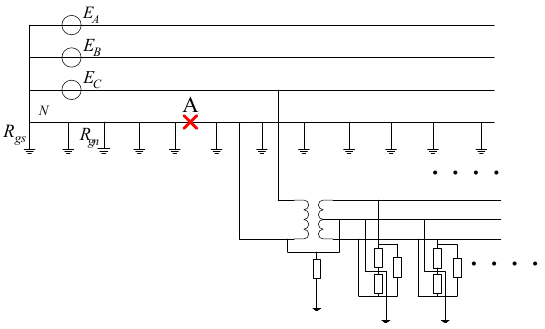
Figure 15. One broken neutral point near the monitored service transformer.